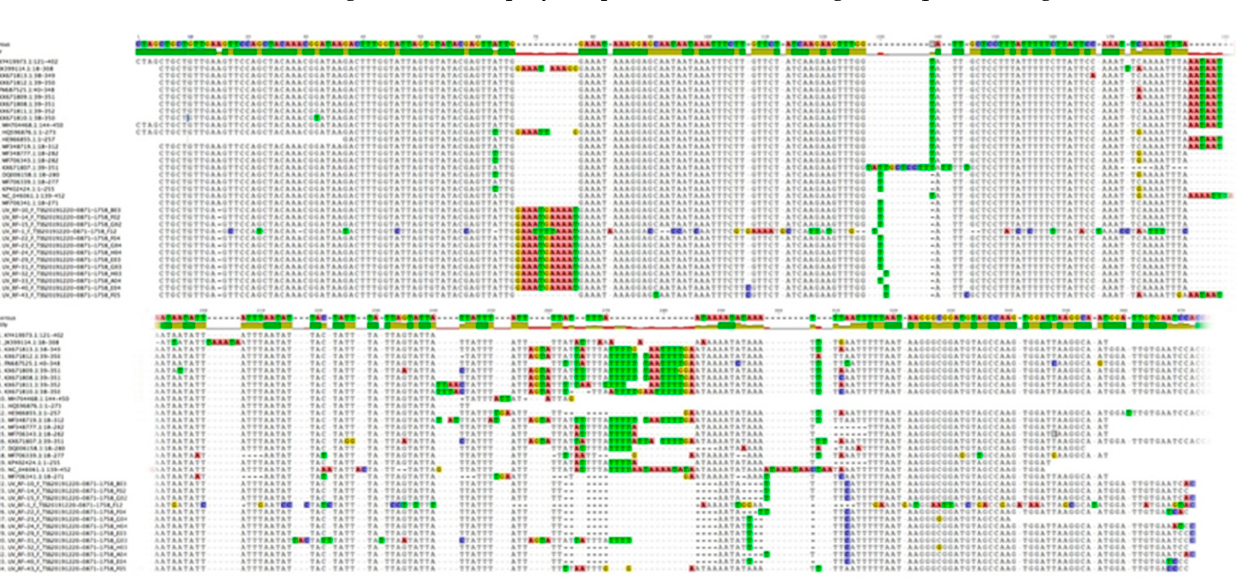
Figure 5. Multiple sequence alignment of the trnH-psbA sequences of U. villosa from Pakistan, different colors indicate insertions and deletions as well as SNPs within the trnH-psbA region.